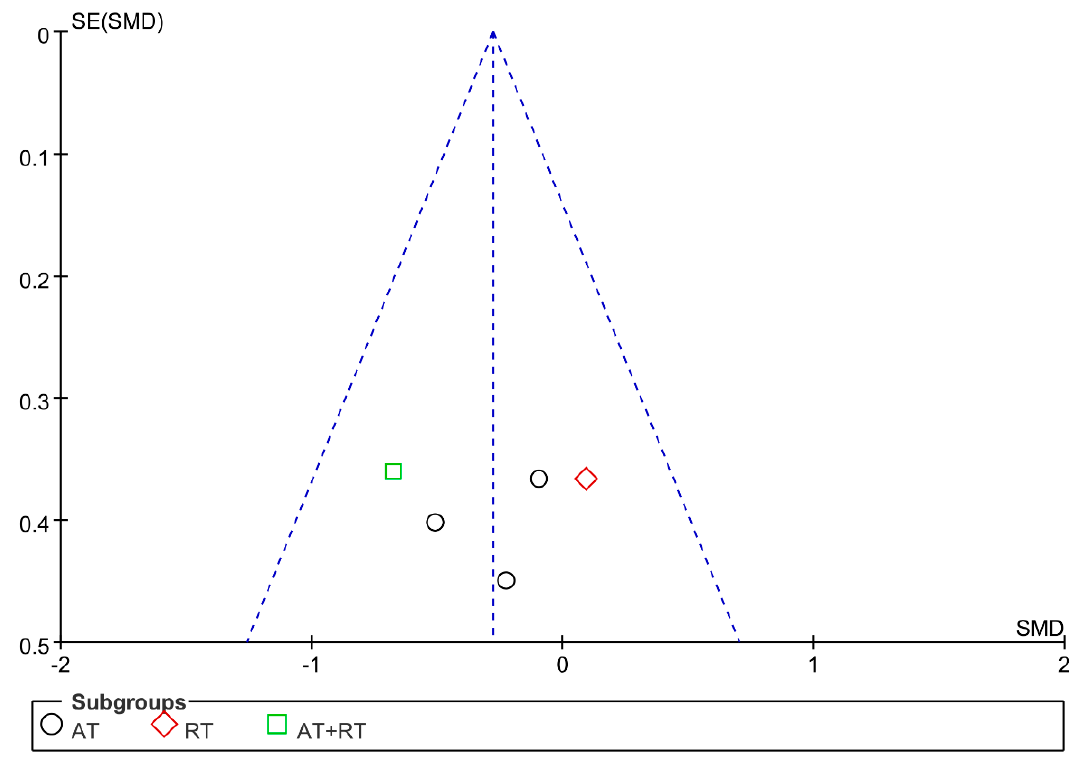
Figure 6. Publication bias of the influence of different exercise modalities on the level of IL-6 in adolescents with obesity.